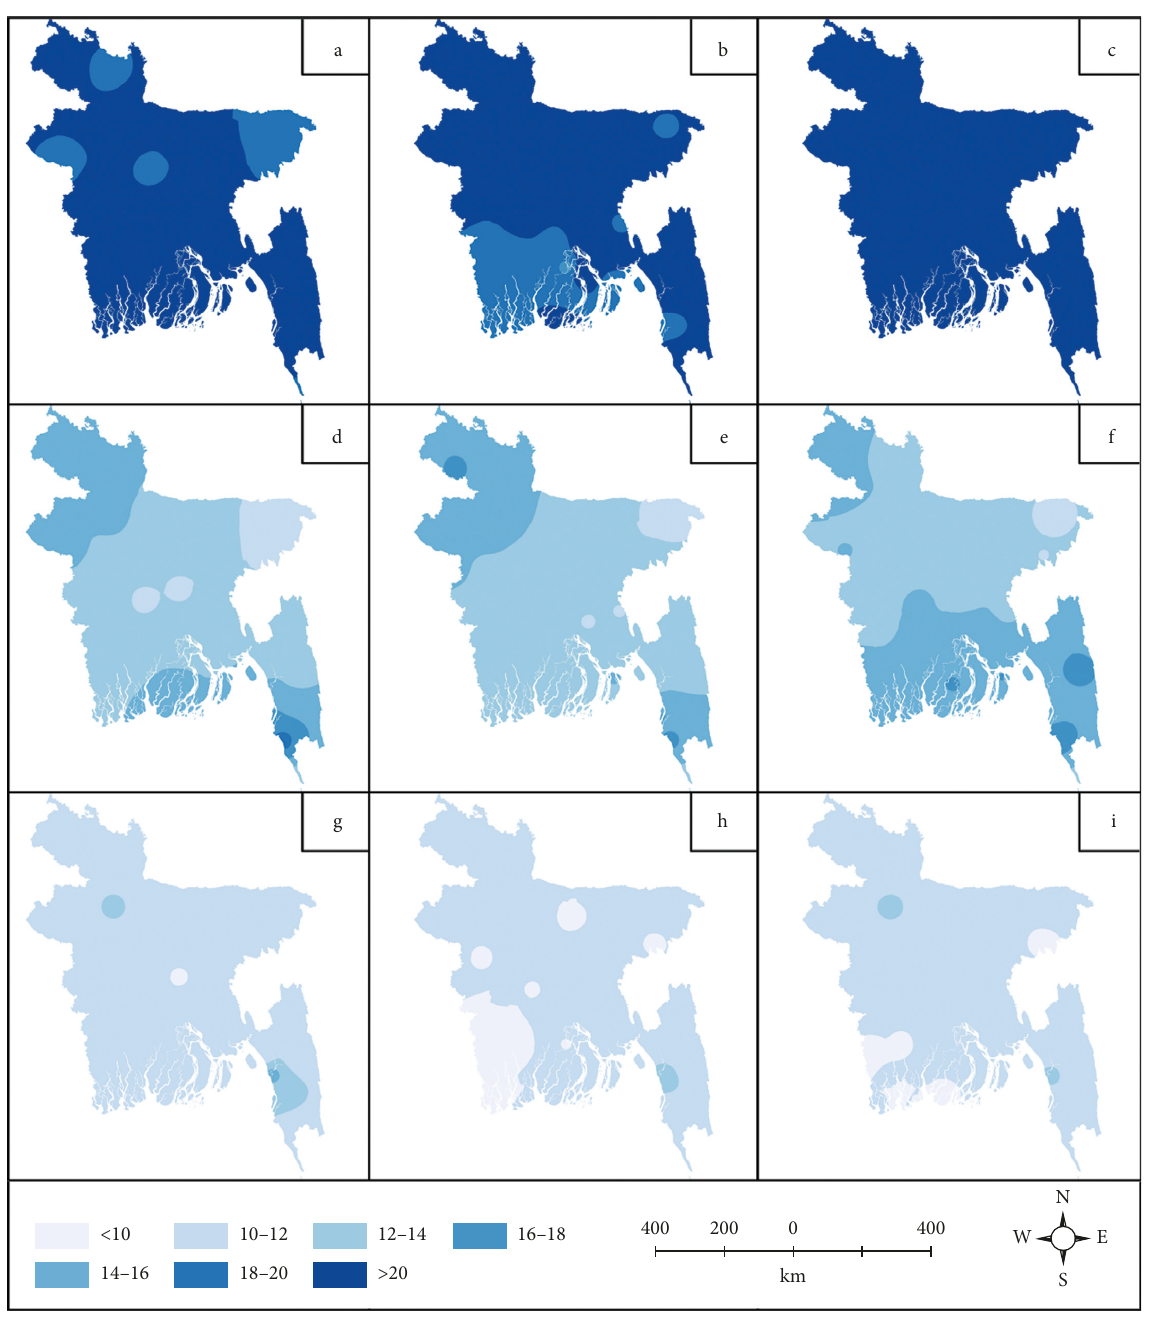
Figure 6: Decadal analysis of seasonal PCI of NDJF for (a) 1980–1989, (b) 1990–1990, and (c) 2000–2011; MAMJ for (d) 1980–1989,